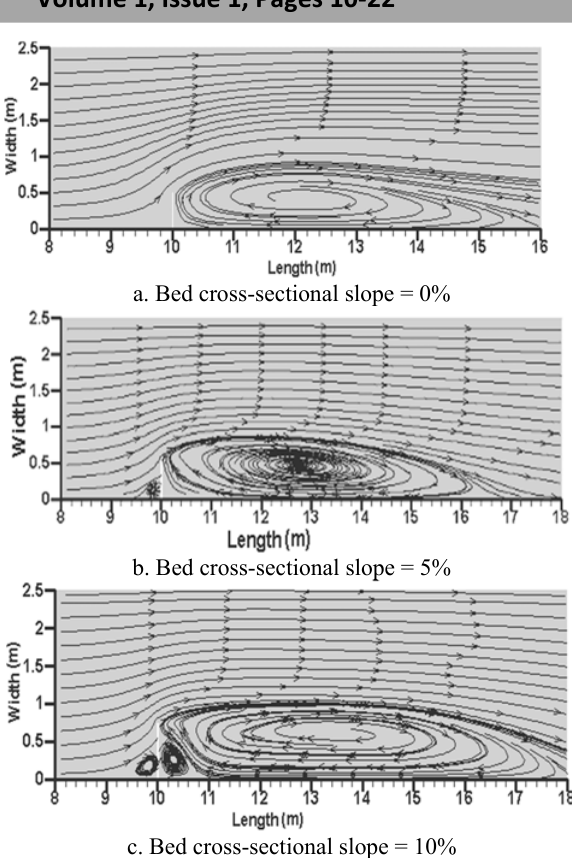
Fig.13 Streamlines at z= 0.175m around the vertical groyne The other numerical tests have shown that by decreasing the structural slope of the groyne, the reattachment length decreased and the maximum reattachment length occurred around the vertical groyne (see Fig. 14).